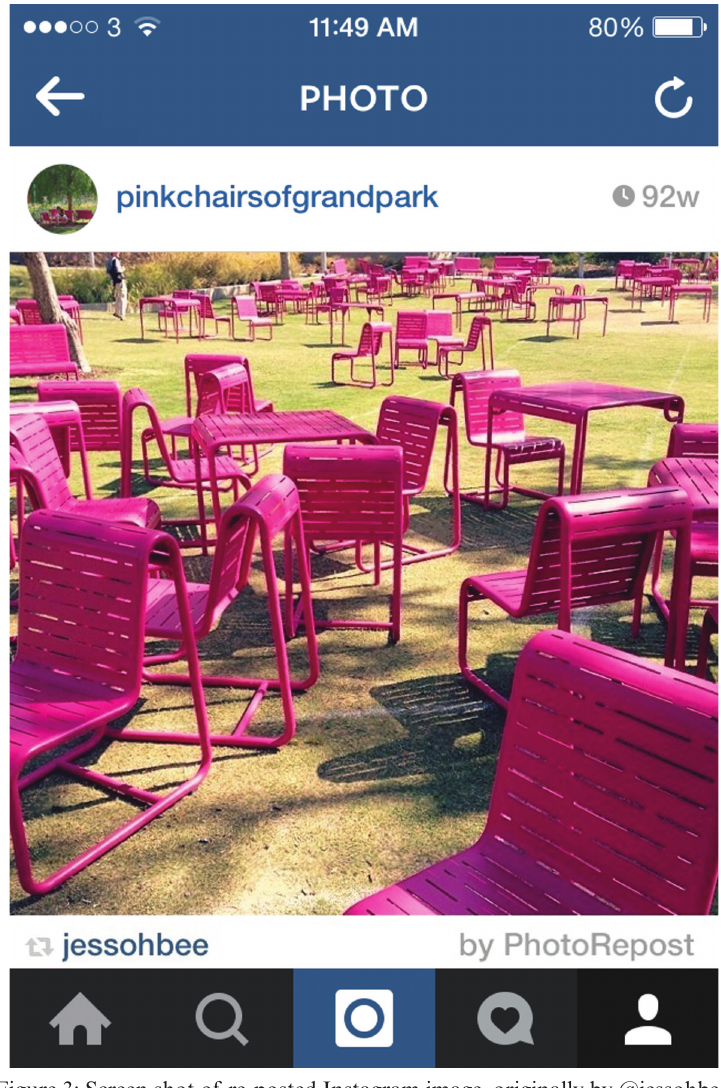
Figure 3: Screen shot of re-posted Instagram image, originally by